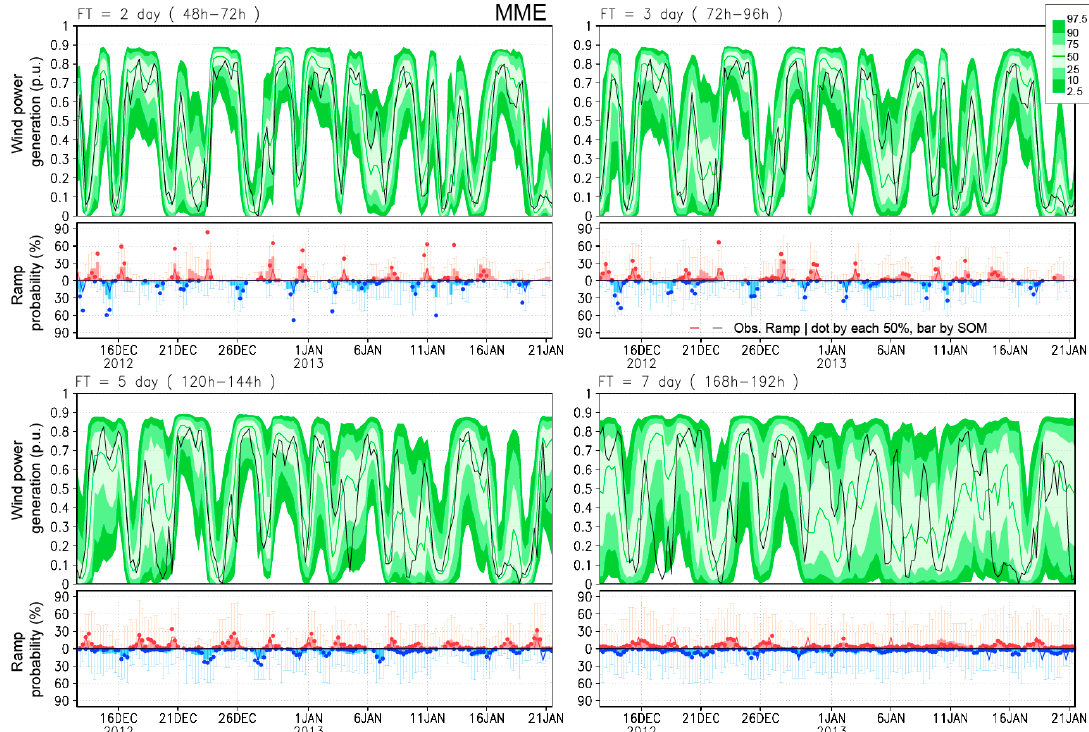
Figure 7. Forecasted 6-h wind power generation obtained from the hybrid ensemble for two-day, three-day, five-day, and seven-day forecasts around 1 January 2013. The black line represents the observed wind power generation. Forecasted PDFs of wind power generation obtained from the hybrid ensemble are represented by green shading. Each figure at the bottom shows the forecasted ramp probability obtained from the SOM nodes and the medium of each ensemble, as represented by red and blue bars and dots, respectively. Observed ramp-up and ramp-down events (actual state) are represented by the red and blue lines, respectively.